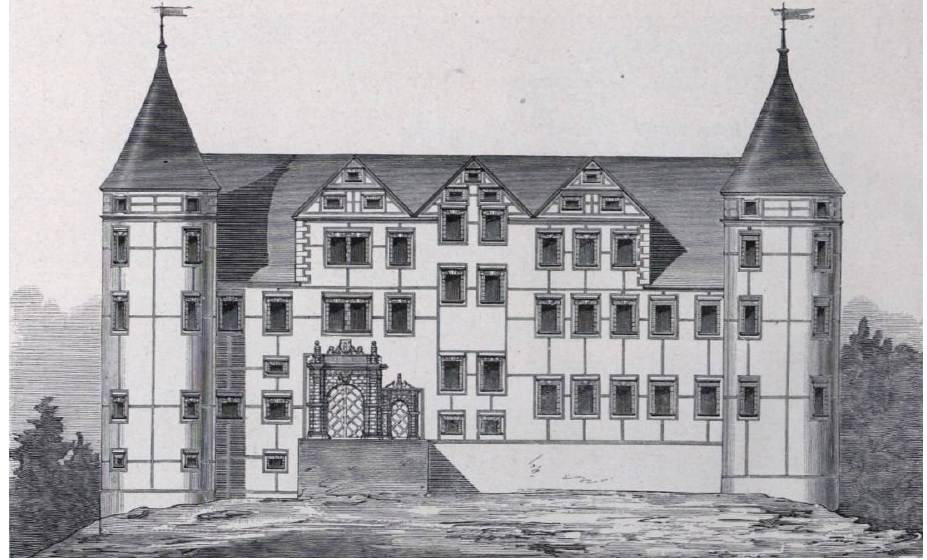
Figure 20. Reconstruction of the sgraffito frame decoration on the front elevation of the palace in Świny, completed by Carl Moritz in 1908. Source: Schlesische …, p. 529.